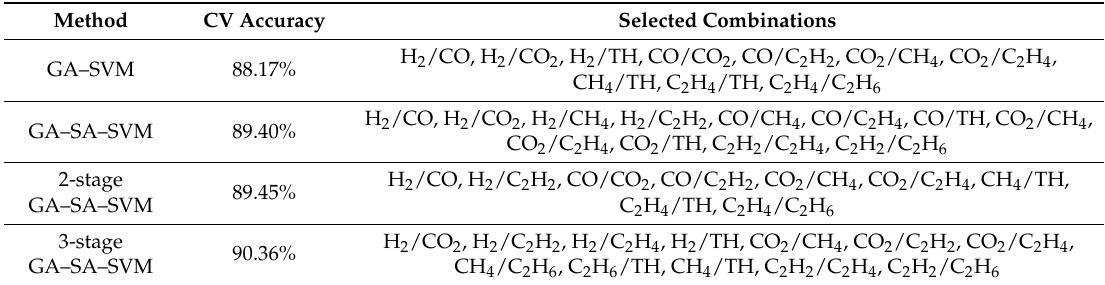
Table 5. Result of DGA selections.